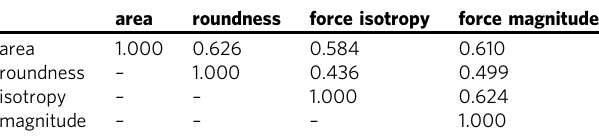
Table 1 Correlations between cellular properties (area, roundness) and force characters (force isotropy,